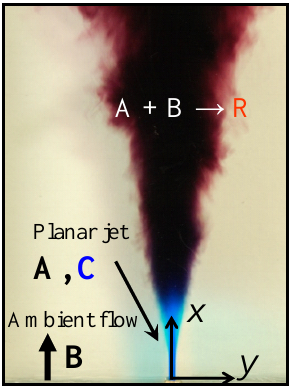
Fig. 1 Snapshot of the planar jet with the chemical reaction. The reactants A and B are premixed into the jet flow and the ambient flow, respectively. The non-reactive species C is also premixed into the jet